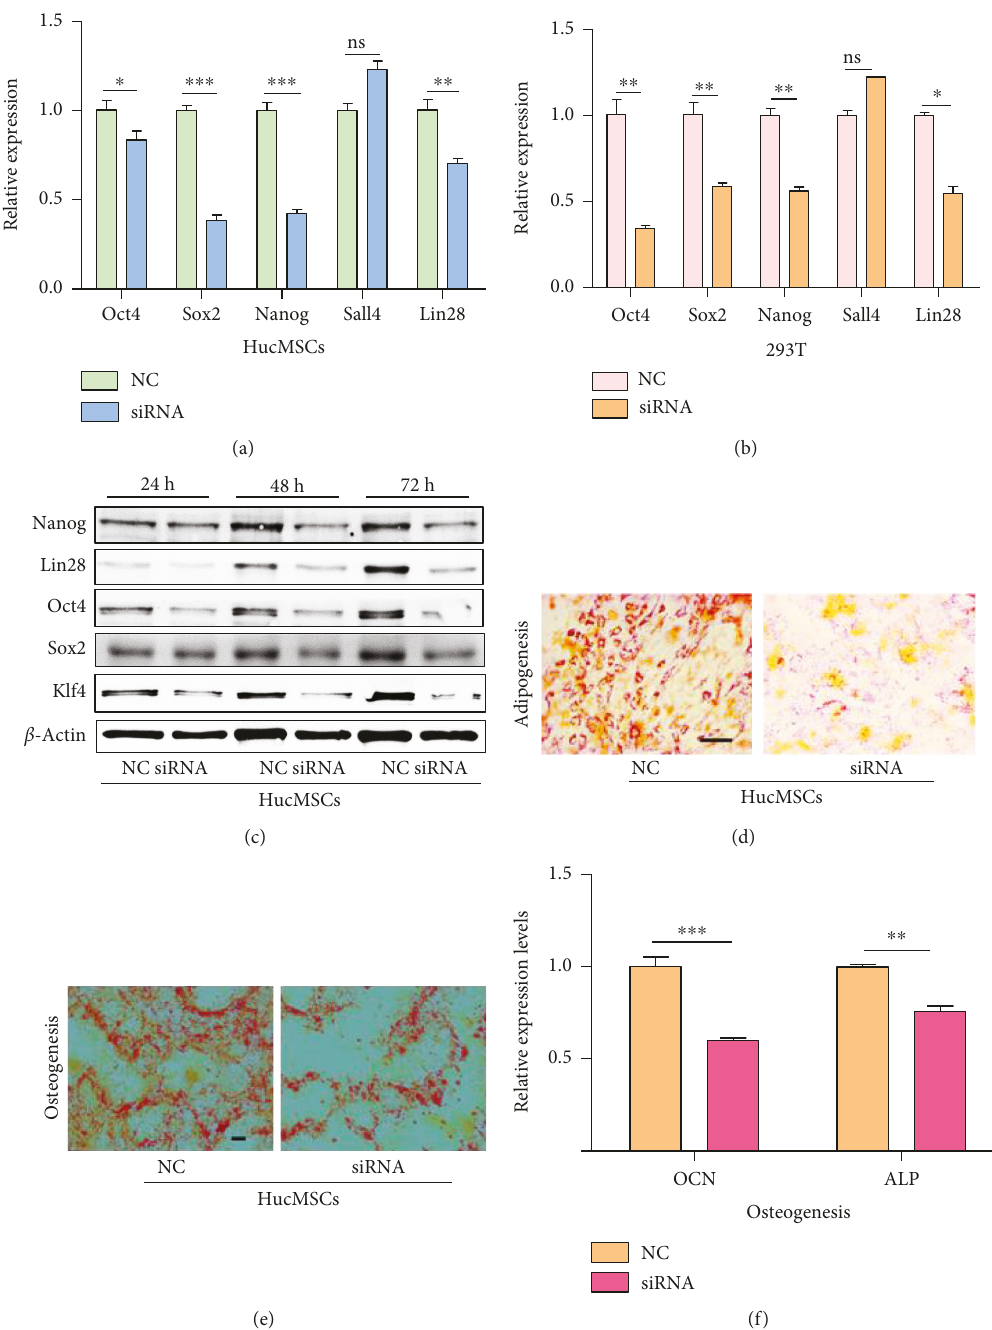
Figure 5: Knockdown of CDR1as inhibited the di ff erentiation of hucMSCs. (a) The expression levels of STFs in hucMSCs transfected with siRNA or control. (b) The expression levels of STFs in 293 T cells transfected with siRNA or control. (c) Western blot analysis for the expression of Oct4, Lin28, Nanog, Klf4, and Sox2 in hucMSCs transfected with siRNA or control for 24 h, 48 h, and 72 h, respectively. (d) Adipogenic di ff erentiation of hucMSCs after transfection with siRNA or control. (e) Osteogenic di ff erentiation of hucMSCs after transfection with siRNA or control. (f) RT-qPCR for detecting the expression levels of OCN and ALP. ns: no signi fi cance; ∗ P < 0 05 ; ∗∗ P < 0 01 ; ∗∗∗ P < 0 001